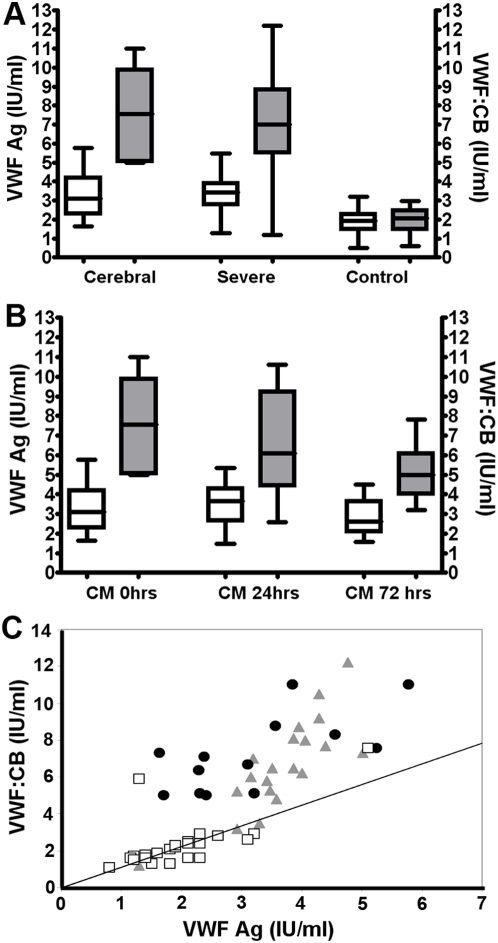
Severe Plasmodium falciparum malaria influences plasma VWF antigen level and collagen binding activity.(A) Plasma VWF∶Ag levels (white bars – left Y axis) were measured by ELISA, and VWF activity by collagen binding activity (VWF∶CB) (grey bars – right Y axis). Each plasma sample was tested in duplicate at three dilutions, and median values for each group are shown. VWF∶Ag and VWF∶CB levels were markedly elevated in patients with cerebral malaria and in children with severe malaria at presentation compared to levels in healthy control children. (B) In a cohort of children with cerebral malaria (CM), the time-course of VWF∶Ag and VWF∶CB levels following admission and commencement of anti-malarial therapy was assessed using follow-up plasma samples collected after 24 and 72 hours respectively. (C) Although both VWF∶Ag and VWF∶CB were increased in all cases of P. falciparum malaria, the relative increase observed in plasma VWF∶CB levels was significantly higher (p<0.05), such that the ratio of CB to Ag was consistently >1 in children with CM (n = 13; •) or SM (n = 20; ▴) at presentation compared to healthy control subjects (n = 25; □). (Hashed line indicates 1∶1 ratio).